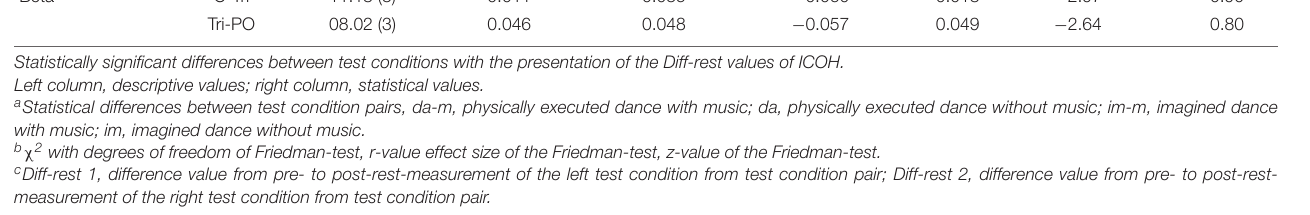
measurement of the right test condition from test condition